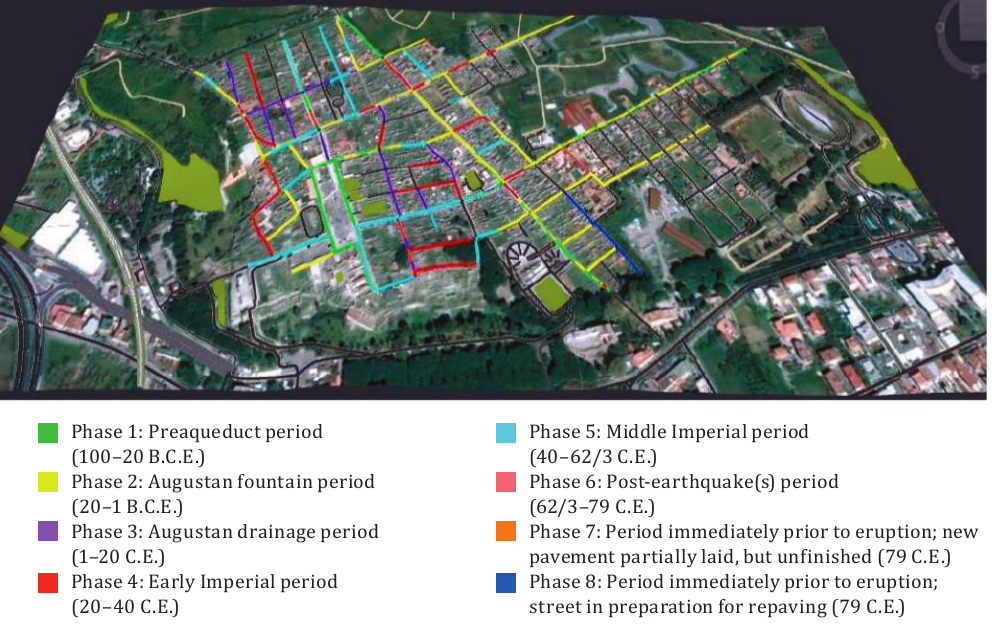
Figure 3. GIS integration in Infraworks BIM